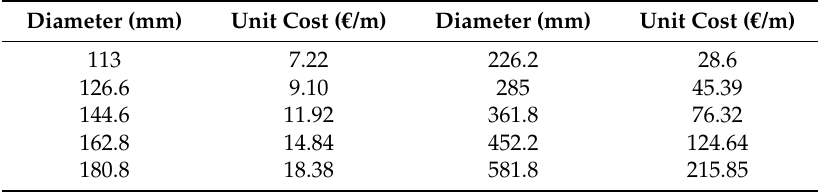
Figure 4. Layout of Balerma network (BIN) [21]. Table 5. Diameter options and associated unit costs of Balerma network